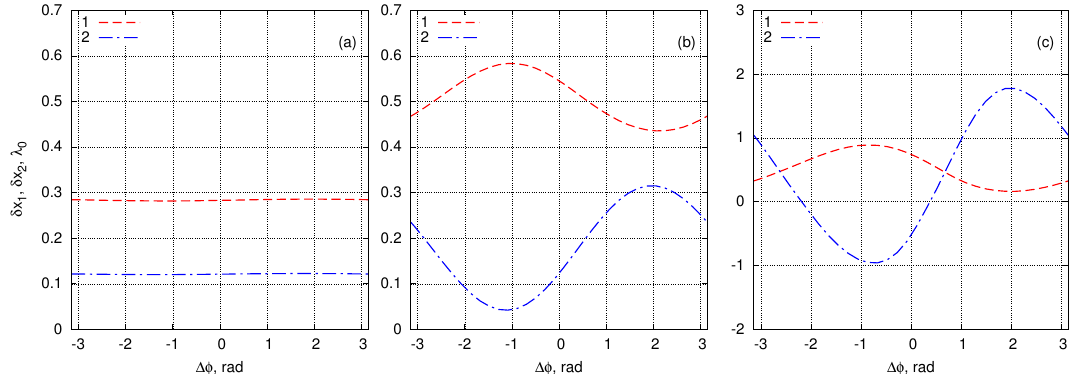
Figure 13. Space shifts of the breathers depending on the relative phase ∆ φ for different wave steepnesses and the relative velocity ∆ V = 20%. Panels ( a – c ) correspond to experiment 1 , experiment 2 , and experiment 3 ,